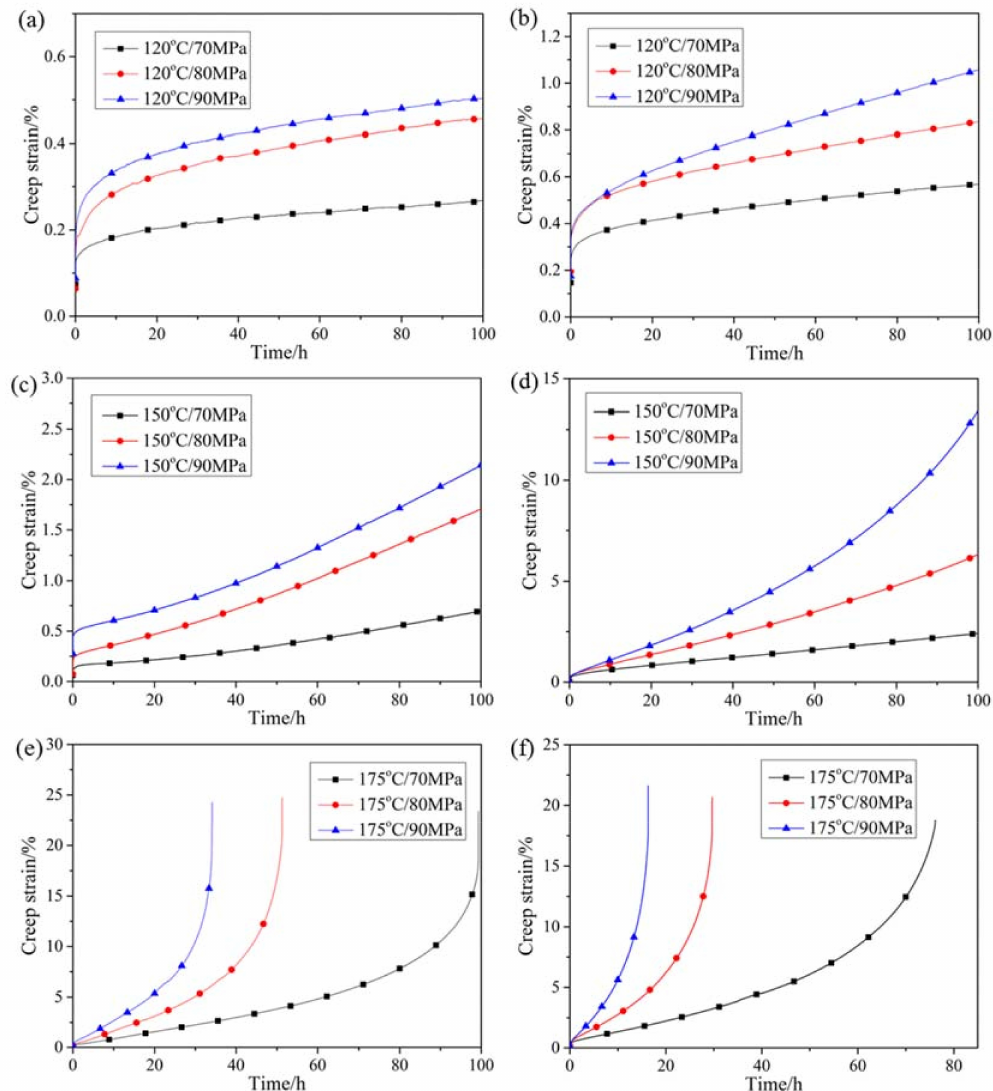
Figure 4. Creep curves of ( a , c , e ) HRRed and ( b , d , f ) T5 specimens tested at 120–175 ◦ C and under 70–90